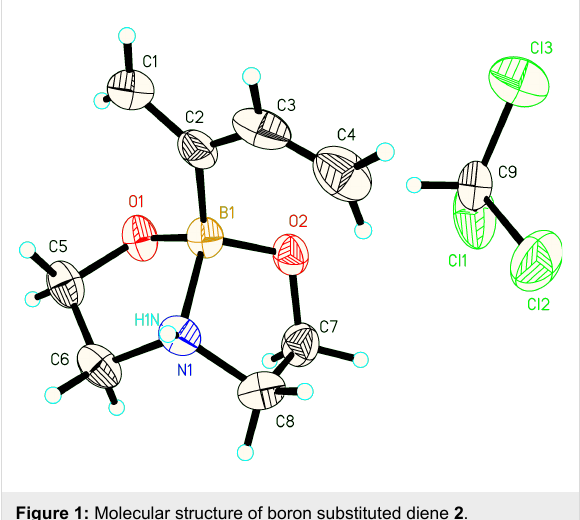
Figure 1: Molecular structure of boron substituted diene 2 .